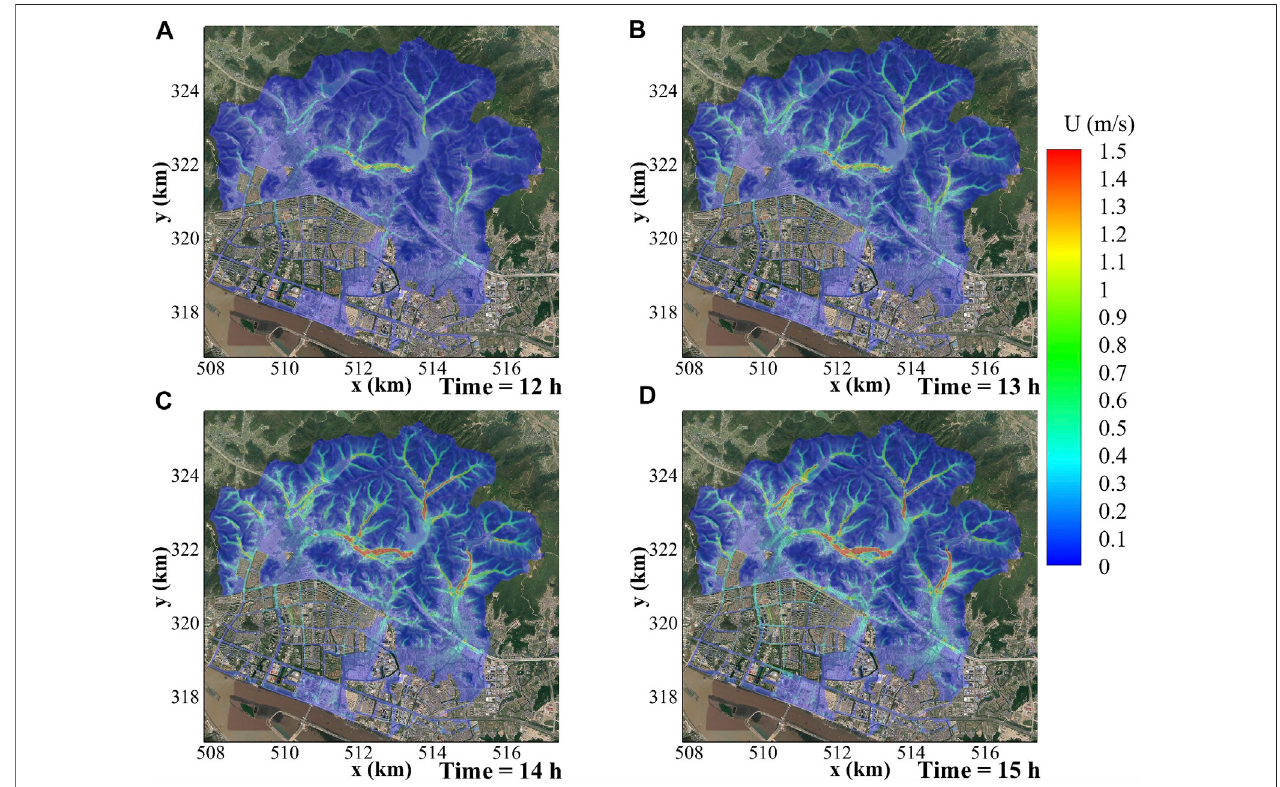
FIGURE 9 | Temporal and spatial evolution of fl ow velocity for CSWM in Case 2 at (A) 12 h, (B) 13 h, (C) 14 h and (D) 15 h.